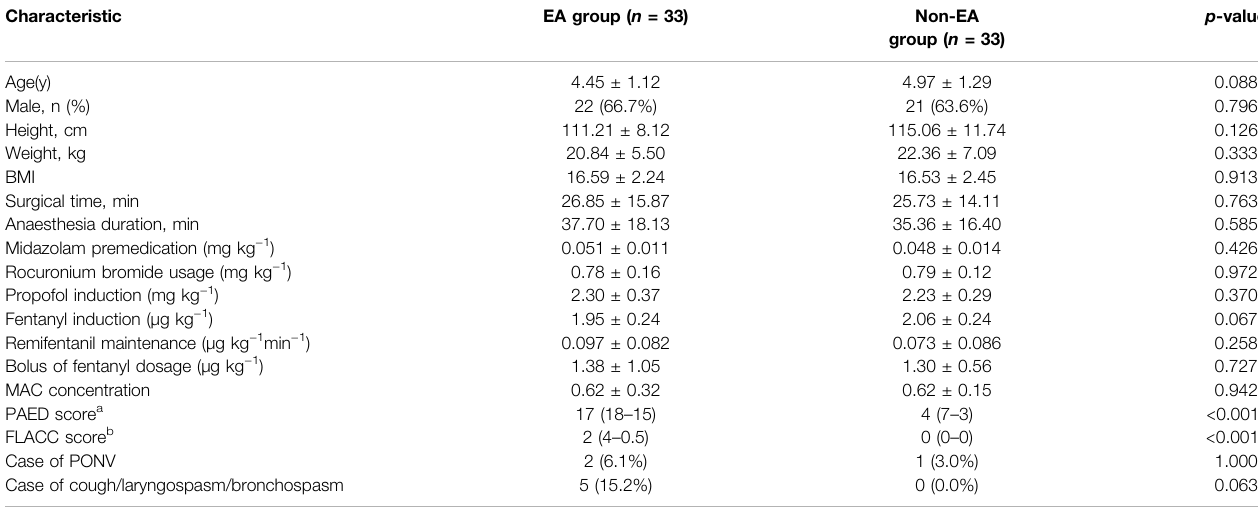
TABLE 1 | Characteristics of post-operative emergence agitation (EA) and non-EA patients.